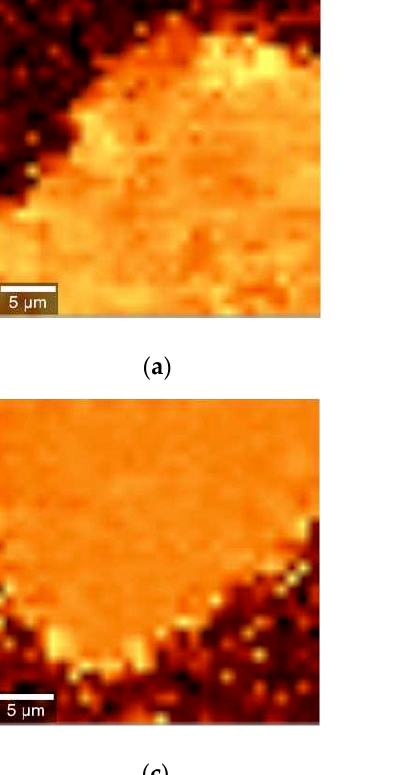
Figure 5. Typical Raman spectra and micrographs of cream (( a ) and ( c ), respectively) and gel (( b ) and ( d ), respectively) containing curcumin before and after the irradiation in the absence of nail, where 1 — Raman spectrum of aggregated curcumin before irradiation, and 2 — Raman spectrum of curcumin after irradiation. PDT with both cream and gel was put on the nail and the Raman spectra were recorded and compared with the control (nail treated with urea, but not treated with any of the curcumin